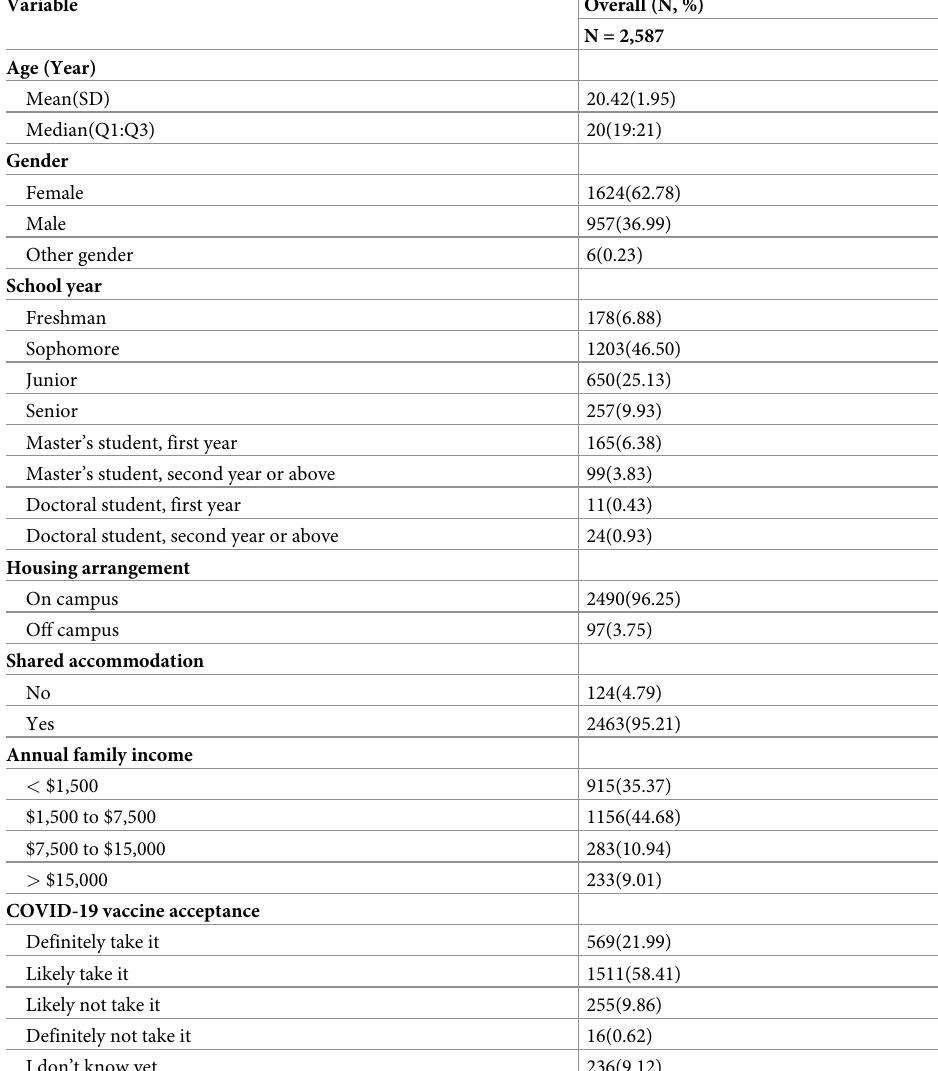
Table 1. Sample characteristics among Chinese college